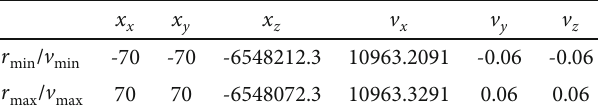
Figure 9: Sensitivity index for combinations of velocity parameters. Table 7: The range of position and velocity